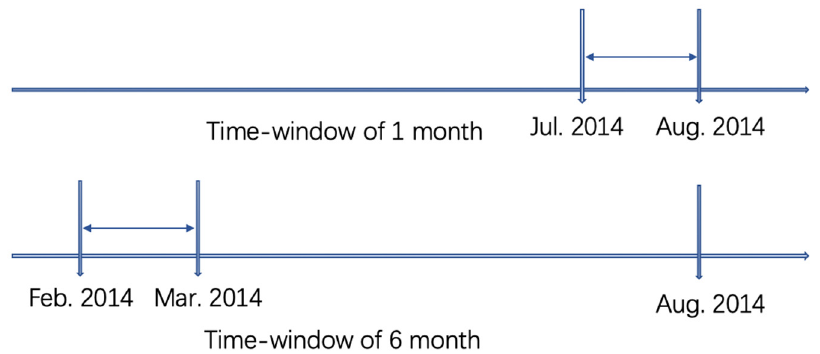
Figure 1. Schematic diagram of generation of 1-month time window and 6-month time window experimental group.